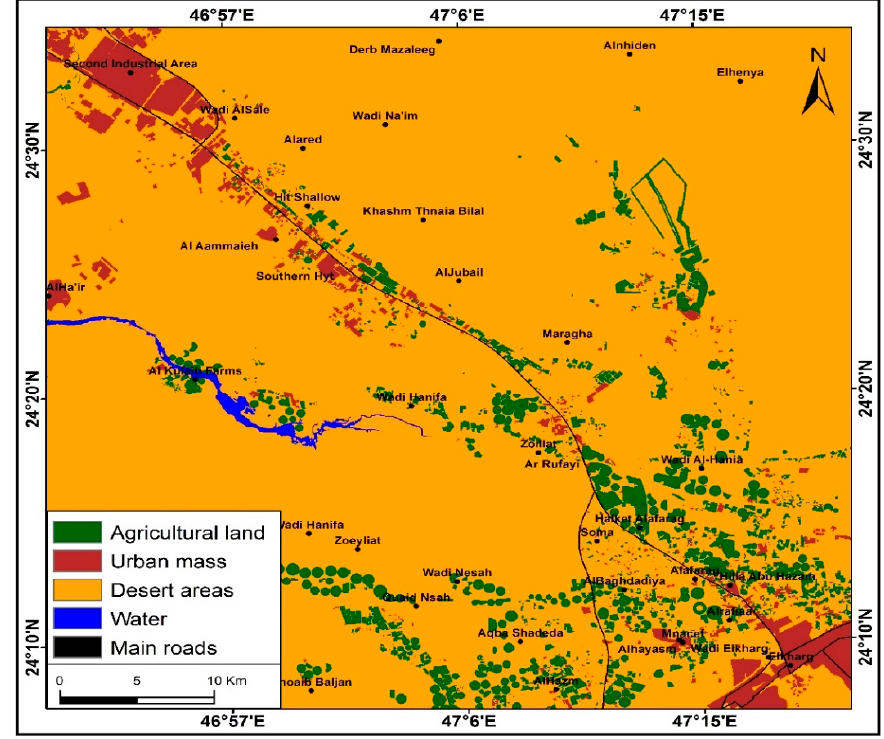
Figure 3. The land use of the rural–urban continuum between Ar Riyadh and Al Kharj cities, 1988.